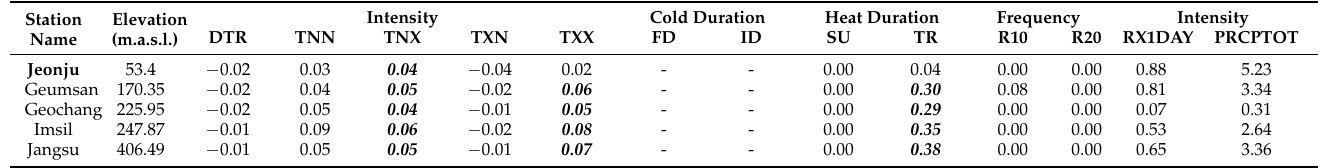
Table A14. Trend magnitudes for the month of August in the UGRB for 33 years (1988–2020).